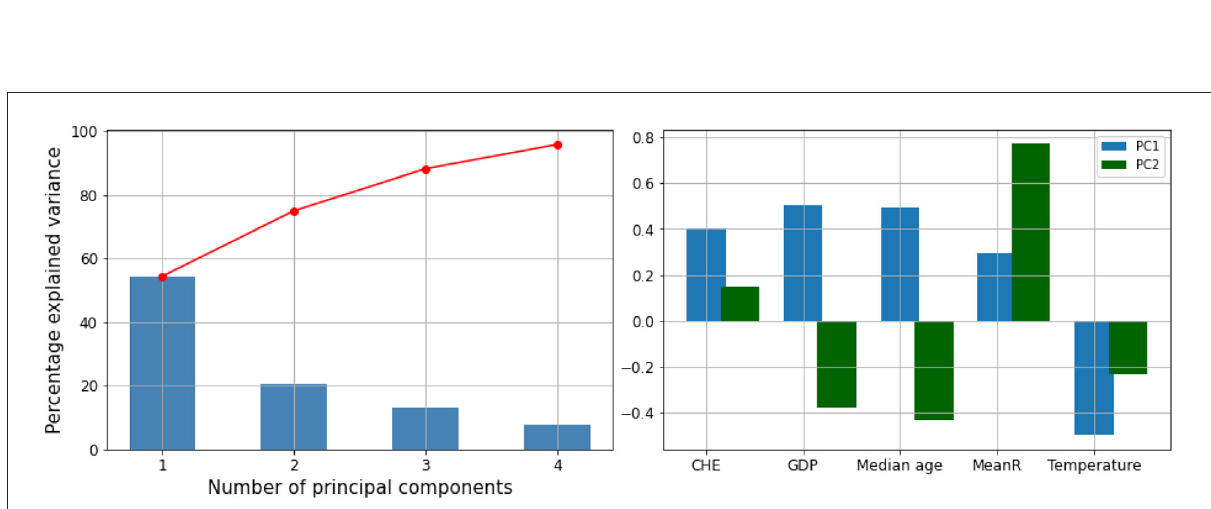
FIGURE8 Principal components (PC) plot from the principal component analysis (PCA) on the pandemic, economic, demographic, and climatic